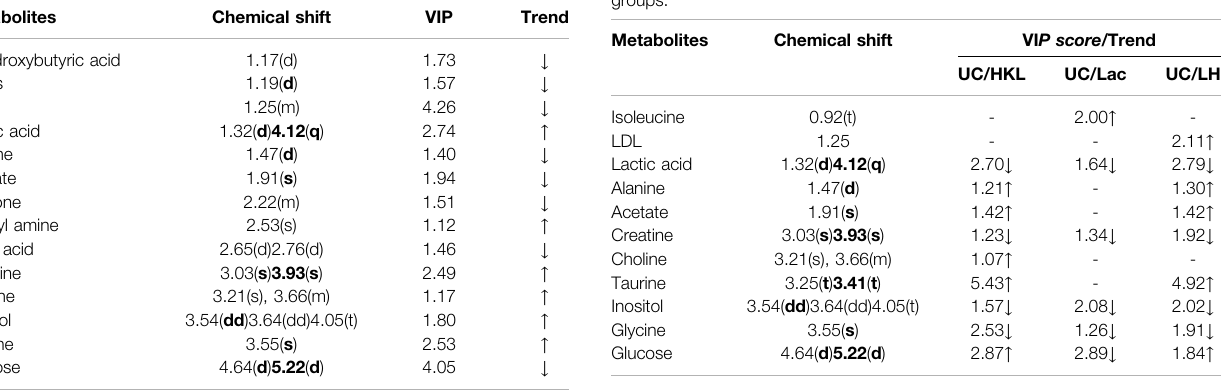
TABLE 2 | Differentially expressed metabolites in the UC and drug intervention